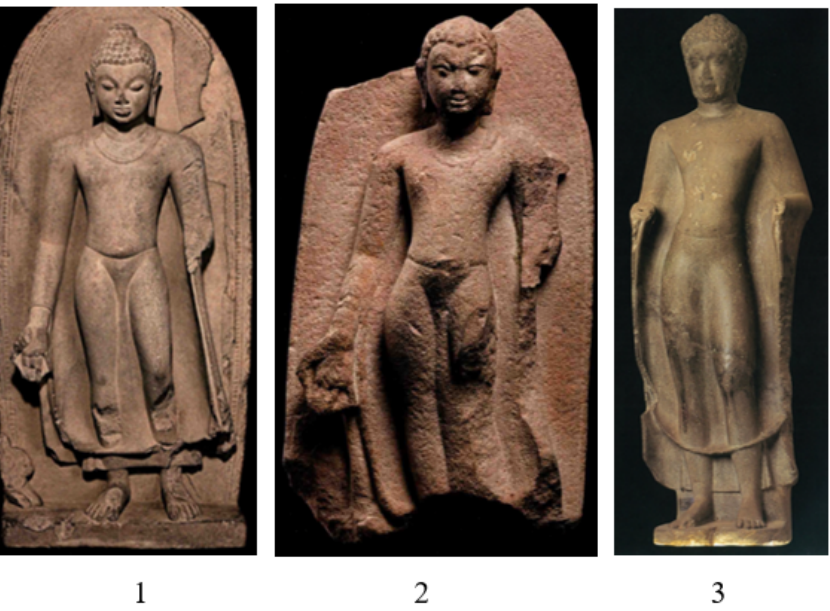
Figure 3. Standing Buddha statues with diaphanous robe draped over both shoulders (type A) in India and Southeast Asia. (1): Buddha, ca. 475, Sarnath region, Uttar Pradesh, India (source: Guy 2014, p. 39, CAT. 10); (2): Buddha, late 5th century to the first half of the 6th century, Wiang Sa district, Surat Thani province, southern Thailand. (Source: Guy 2014, p. 38, CAT. 9); (3): Buddha, second half of the 6th century, Vat Romlok site, Angkor Borei, Ta Keo, Cambodia (source: Jessup and Zephir 1997, p. 147).